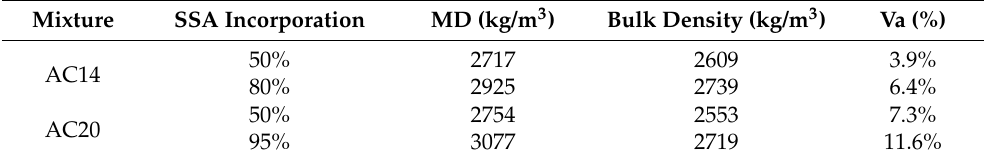
Table 5. Volumetric characterization of the mixtures evaluated in the preliminary study.